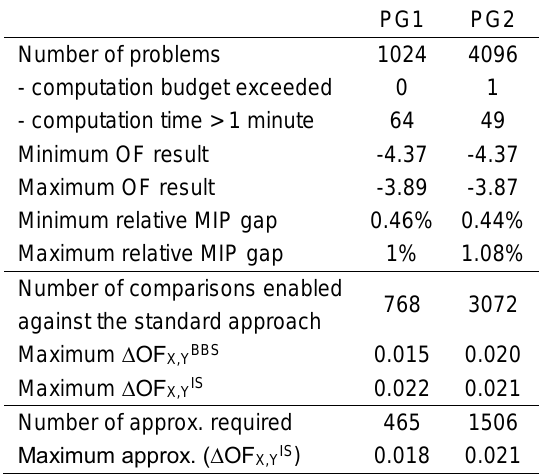
Table 2 . Summary of results per problem group (PG1: state spaces; PG2: MLD control approaches)